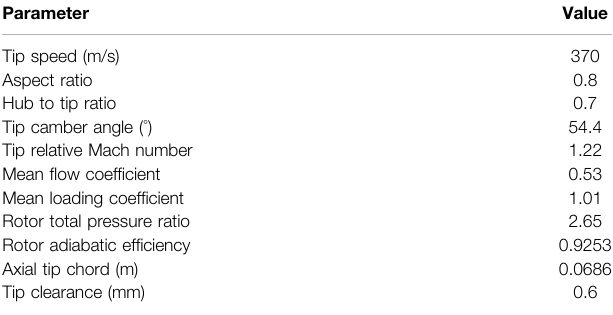
TABLE 1 | Main parameters of the investigated compressor rotor at PE.